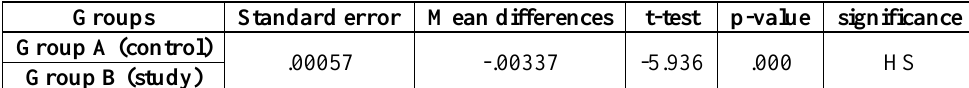
Table 10: t-test analysis of water sorption test